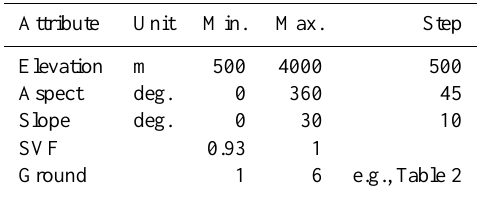
Table 1. Environmental attributes determining the locations for which the sensitivity and uncertainty analyses are performed. The sky view factor (SVF) is a function of slope. For each combination of attributes, a separate sensitivity and uncertainty analysis is per- formed, resulting in a total of 200 simulation locations per ground type. In total, 1200 sensitivity and uncertainty analyses were per- formed.